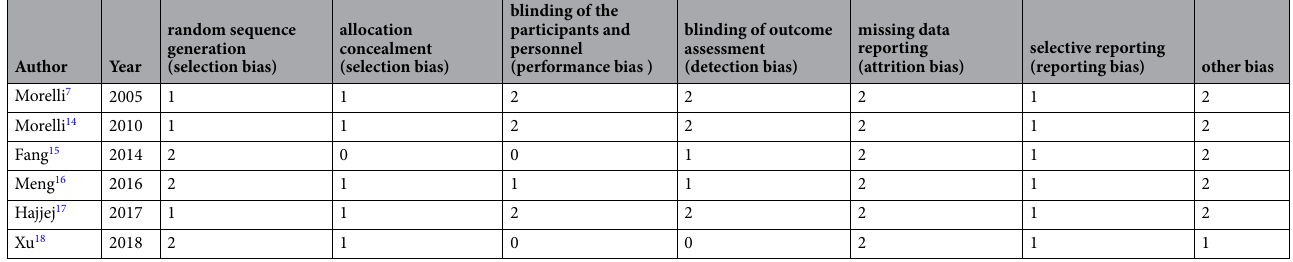
Table 2. Modified Jadad scale. Low risk = 2, unclear risk = 1, high risk =